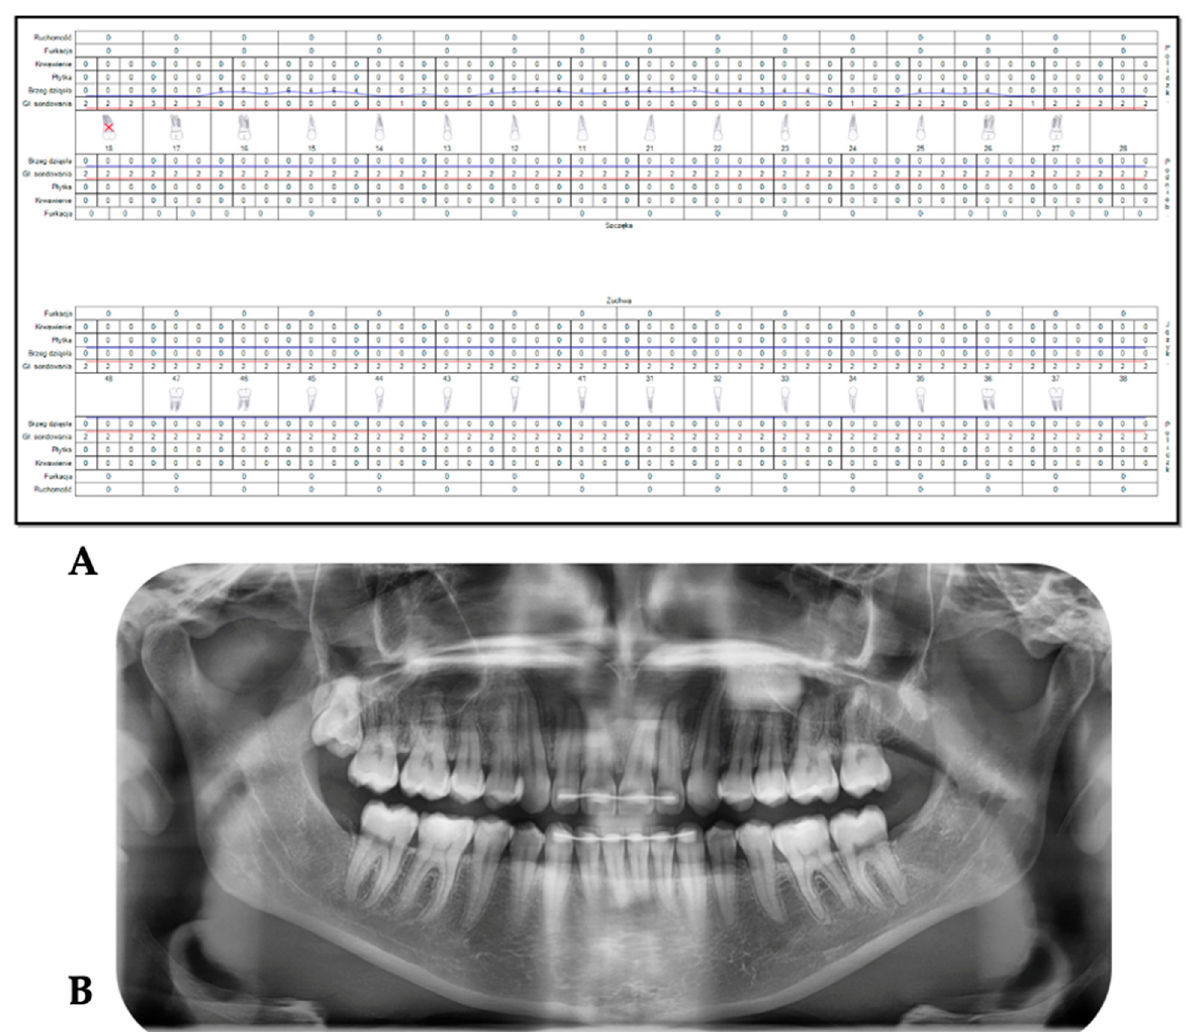
Figure 4. ( A,B ) . Pre-operative clinical and radiographic investigations. Photo ( A ) (top) is the periodontal charting, showing no evidence of any abnormality. Photo ( B ) (bottom) shows no evidence of any hard tissue abnormalities on the orthopantomogram.